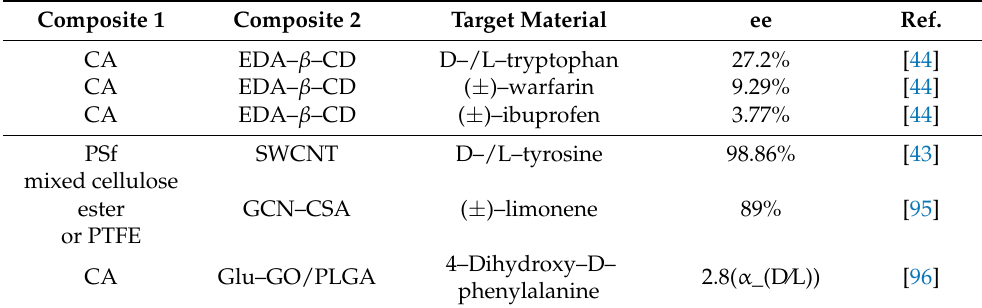
Table 2. Other composite mixed matrix